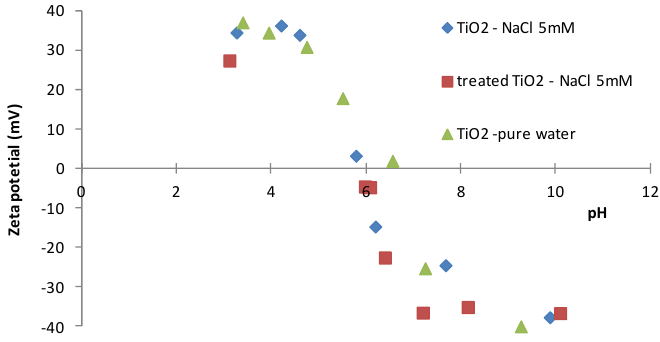
Figure 3. Zetametry results of TiO 2 powder (before and after Na 2 CO 3 treatment) in a NaCl (5 mM)—water solution.